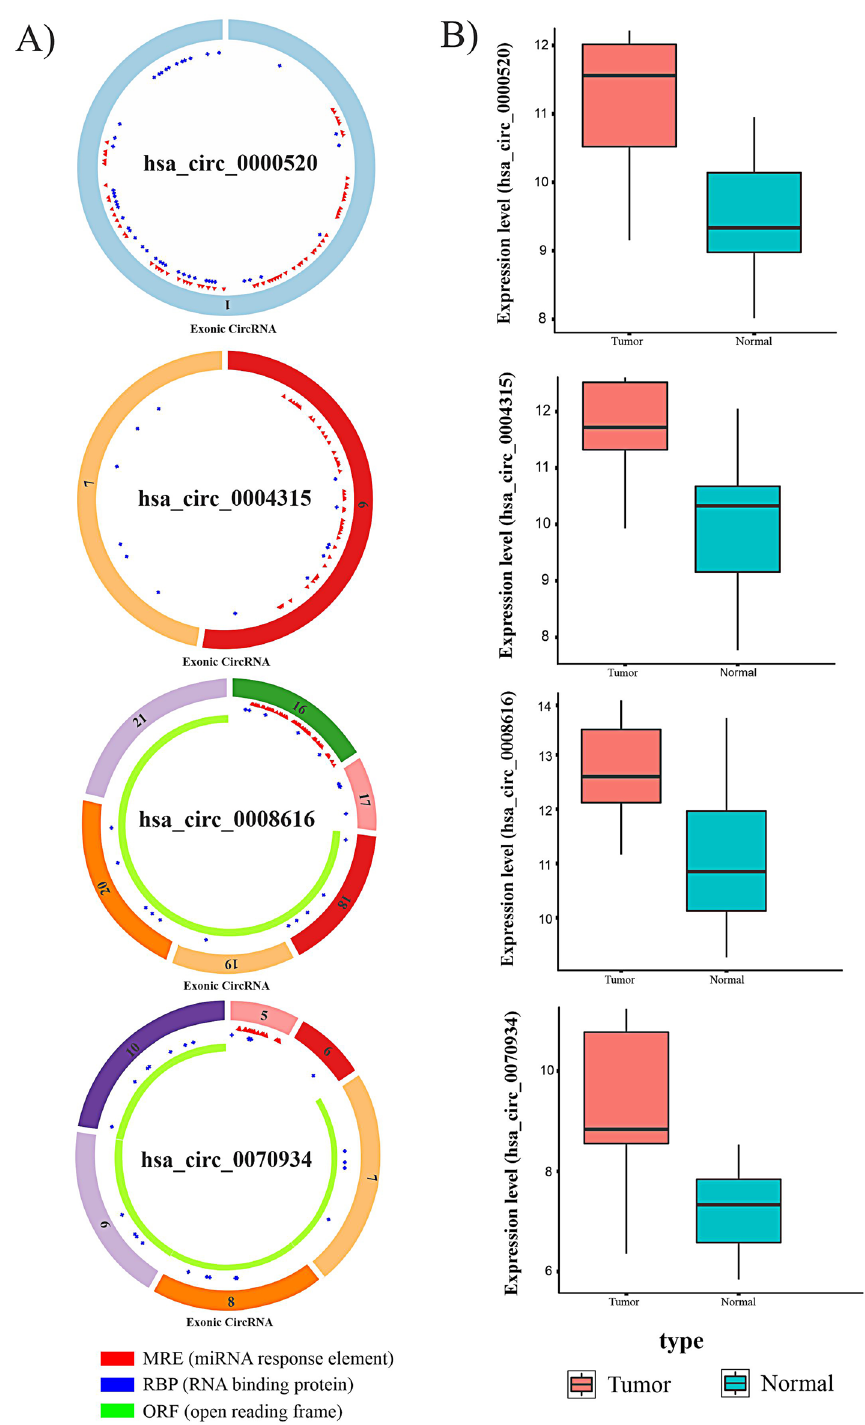
Figure 4. (A) The basic structure of four DECs with MRE, RNA binding protein, and open reading frame information. The schema graphs of four DECs information were downloaded from the CSCD website. ( B) Transcription levels of four DECs with variable expression levels between normal and tumor